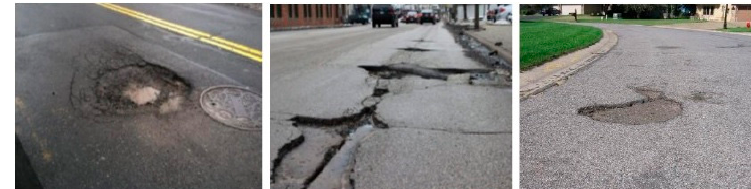
Figure 5. Sample images from potholes dataset. Table 2. Training parameters for YOLOv5 and Faster